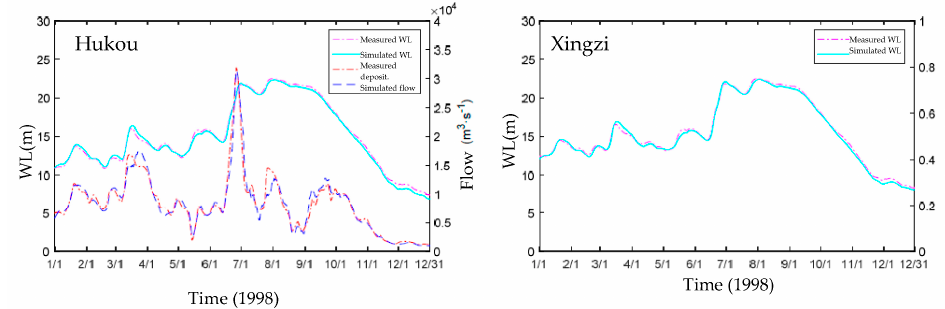
Figure 12. Calibration diagram of the water level and discharge of Poyang Lake in